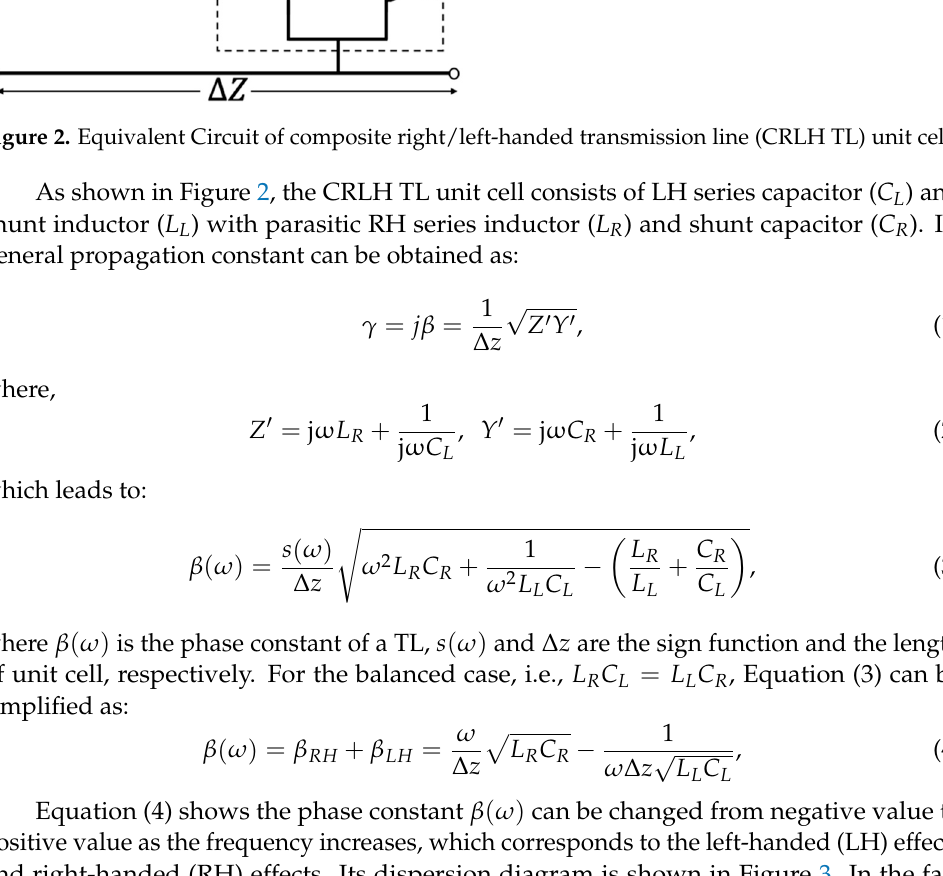
Equation (4) shows the phase constant β ( ω ) can be changed from negative value to positive value as the frequency increases, which corresponds to the left-handed (LH) effects and right-handed (RH) effects. Its dispersion diagram is shown in Figure 3. In the fast wave region where the phase velocity is greater than the speed of light, radiation occurs with frequency-dependent radiation main beam angle θ for a CRLH TL given by Figure 4. Specifically, the radiation angle of the main beam can be expressed as: